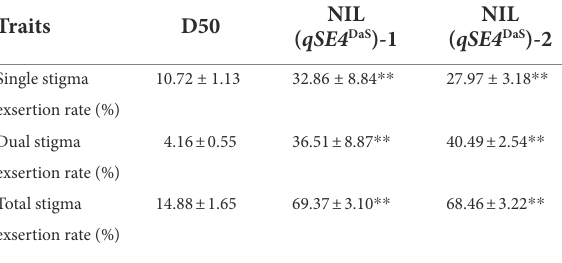
TABLE 1 The stigma exsertion rates of D50, NIL (qSE4 DaS )-1 and NIL (qSE4 DaS )-2.